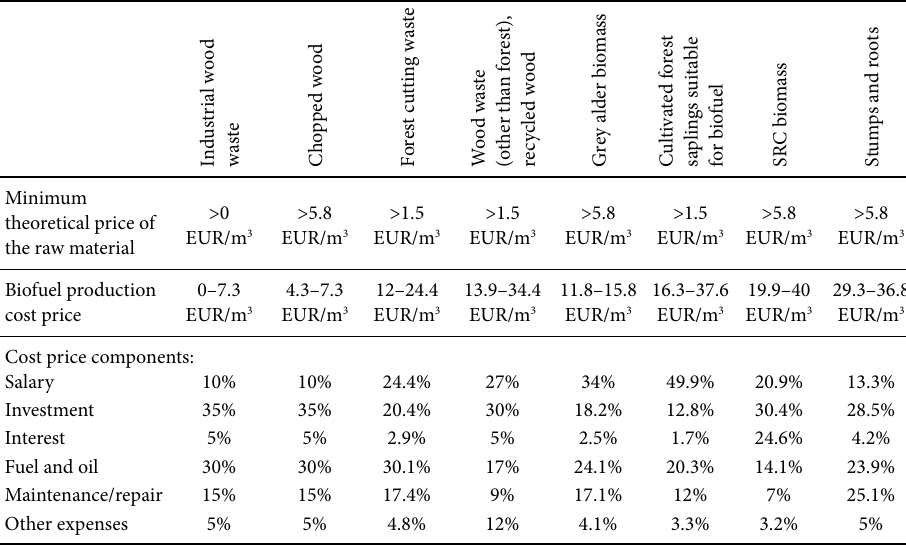
Table 1. Evaluation of wood biofuel production